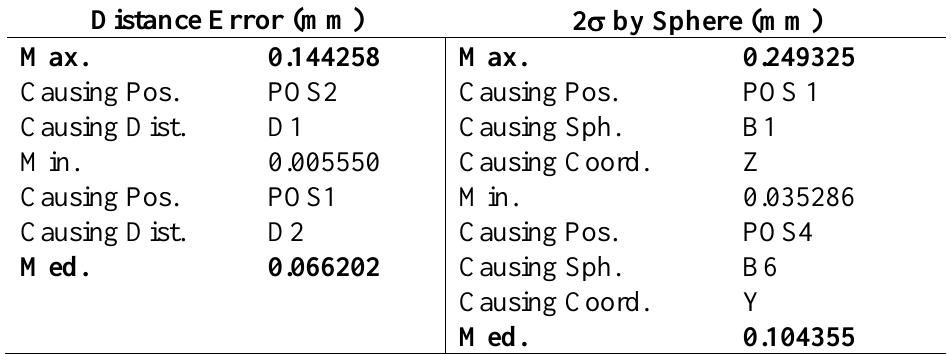
Table 2. Quality indicators for the identified set of model parameters over seven ball bar locations (10780 AACMM positions)